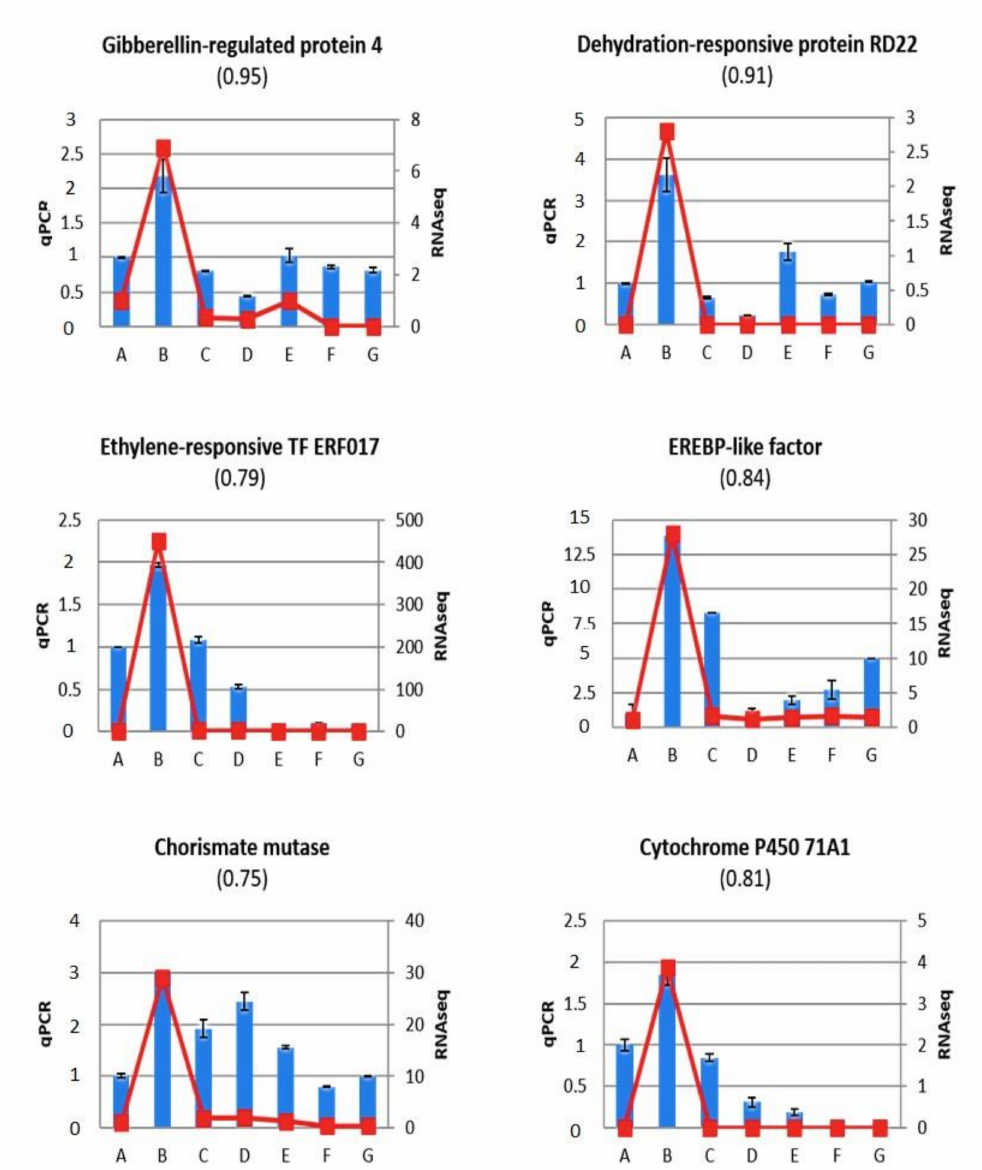
Figure 4. RT-qPCR expression analysis (blue bars) for candidate genes involved in phytohormonal signalling, including a phytohormone related to growth, such as gibberellin (GA) (Prupe.5G193400; gibberellin-regulated protein 4 ); phytohormones related to stress, such as abscisic acid (ABA) (Prupe.1G453700; dehydration-responsive protein RD22 ); ethylene (Prupe.7G194400; ethylene-responsive transcription factor ERF017 and Prupe.4G176200; ethylene responsive element binding protein ( ERBP )- like factor ); salicylic acid (SA) (Prupe.1G393400; chrorismate mutase ; (Prupe.5G164200; cytochrome P450 71A1 ( CYP71A1 ), all selected from the RNA-Seq analysis. Relative gene expression (RGE) in the seven samples: control healthy “GF305” peach rootstocks (A); PPV-infected “GF305” rootstocks showing severe sharka symptoms (B); “GF305” peach rootstocks grafted with healthy “Garrigues” (C); PPV-infected “GF305” rootstocks showing sharka symptoms grafted with healthy “Garrigues” (D); healthy “GF305” peach rootstock grafted with healthy “Garrigues” which were later inoculated with PPV at the end of the first cycle of evaluation (E). “Garrigues” almond samples grafted onto healthy (F) and inoculated “GF305” (G) rootstocks. Error bars in qPCR represent the standard error of three independent biological replicates. Between brackets: Pearson correlation coefficients between FPKM (fragments per kilobase pair of transcript per million mapped reads) values from RNA-Seq (in red lines) and RGE values from